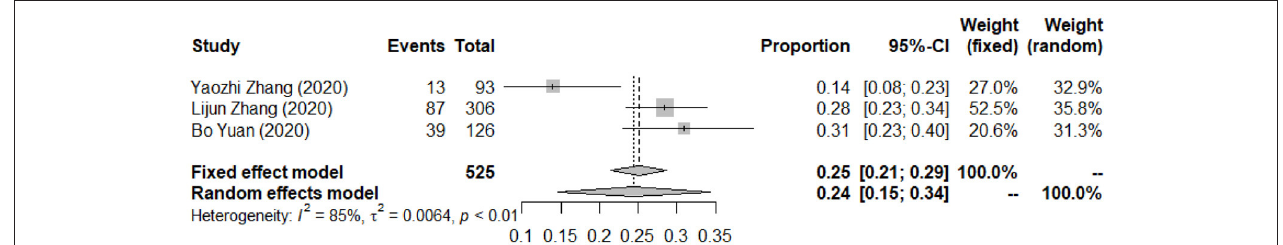
FIGURE 5 | Forest plots of pooled prevalence of post-traumatic stress symptoms among suspected cases.